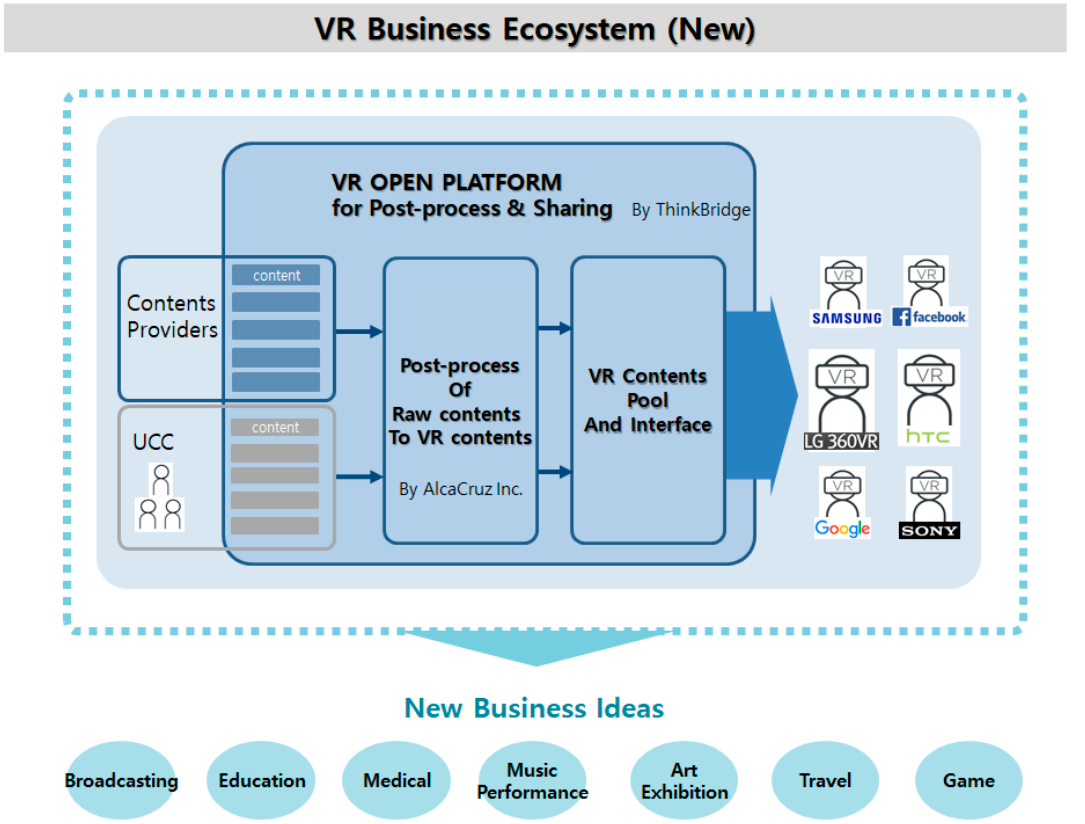
Figure 7. New VR business ecosystem due to the FPSP project.